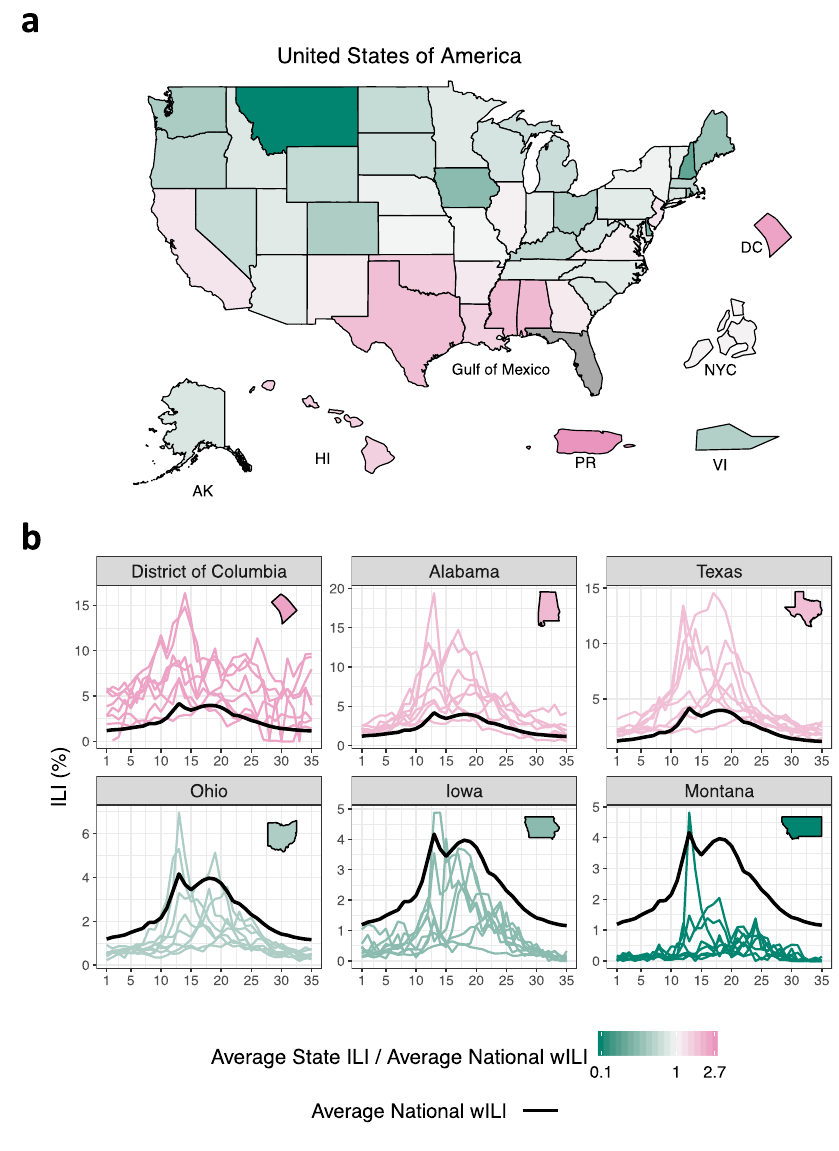
Fig. 1 State-to-state in fl uenza-like illness variability. a Average state in fl uenza-like illness (ILI) relative to average national weighted ILI (wILI). States bordering the Gulf of Mexico tend to have higher ILI than the national average. The geographical sizes of Alaska (AK), Hawaii (HI), Puerto Rico (PR), the US Virgin Islands (VI), New York City (NYC), and the District of Columbia (DC) are not to scale. Data for Florida is unavailable. Averages are based on 2010 through 2017 data. b ILI by season (colored lines) for select states. Black line is national average wILI for reference. Appreciable season-to-season and state-to-state ILI variability